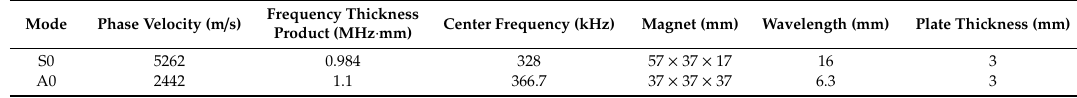
Table 1. The parameters of